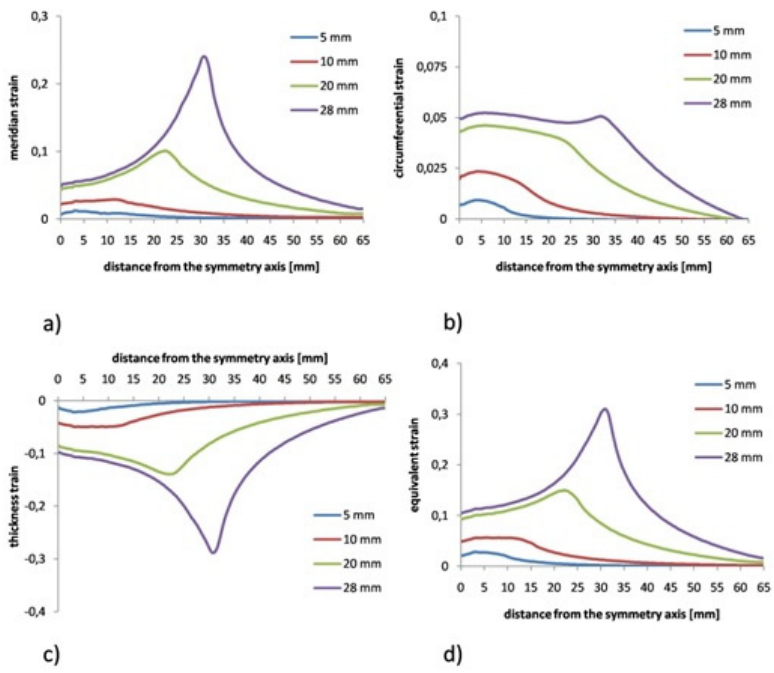
Figure 5. Distribution of the main strains and equivalent strain during the stretching process in friction conditions with a friction coefficient μ = 0.2 due to FEM: ( a ) meridian strain; ( b ) circumferential strain; ( c ) thickness strain; ( d ) equivalent